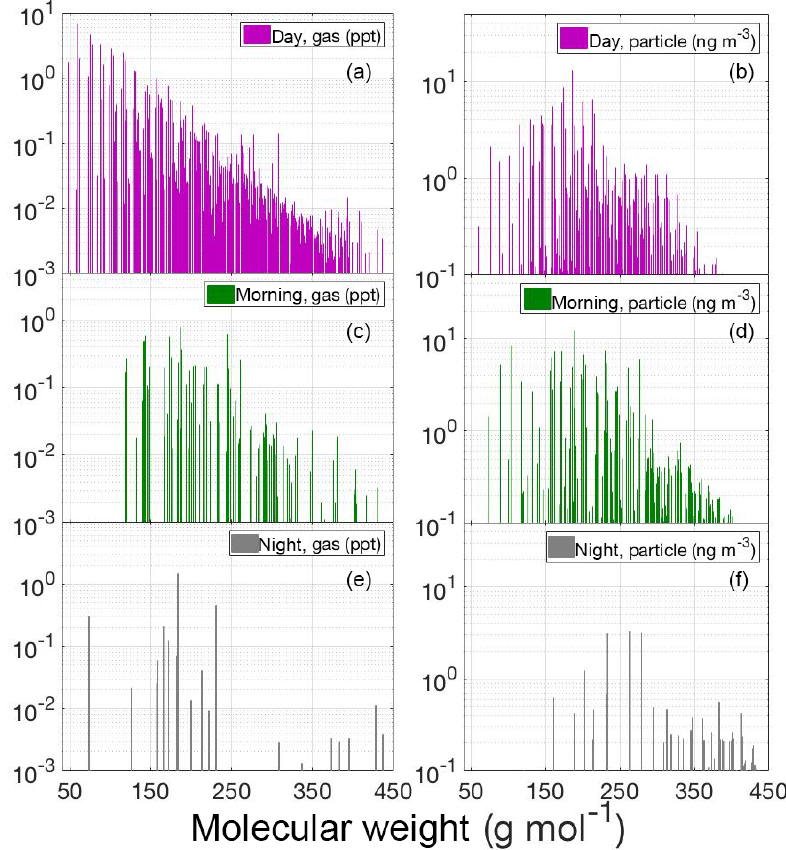
Figure 7. BAECC-median abundance distributions of the organic species comprising the (a, c, e) gas and (b, d, f) particle phases of the (a, b) daytime, (c, d) morning, and (e, f) nighttime subgroups, plotted as a function of their molecular